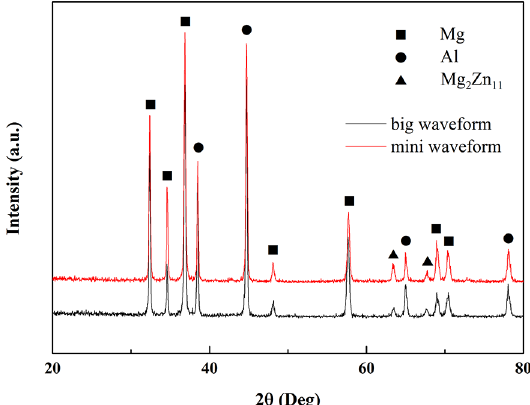
Figure 5. XRD patterns taken from the bonding